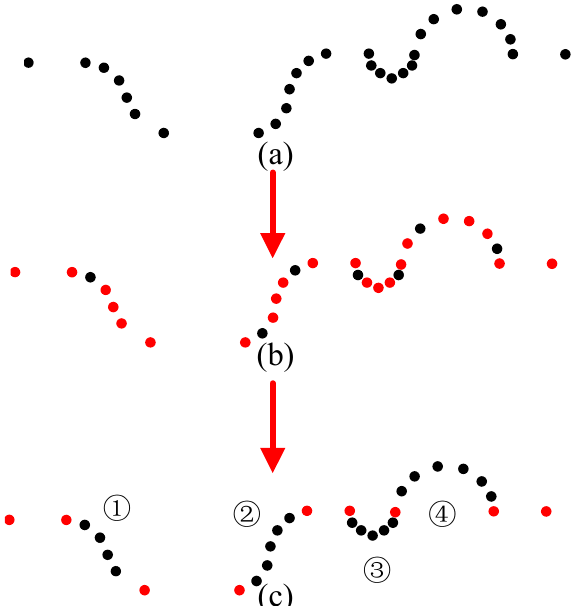
Figure 7. Constant interval division ( a ) CL points ( b ) the characteristic CL points ( c ) the same speed interval.